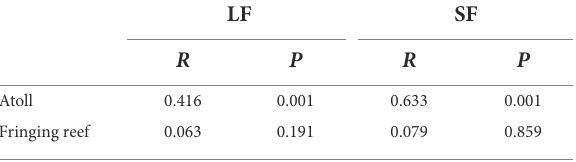
TABLE 1 ANOSIM of bacterial communities among different type reefs.